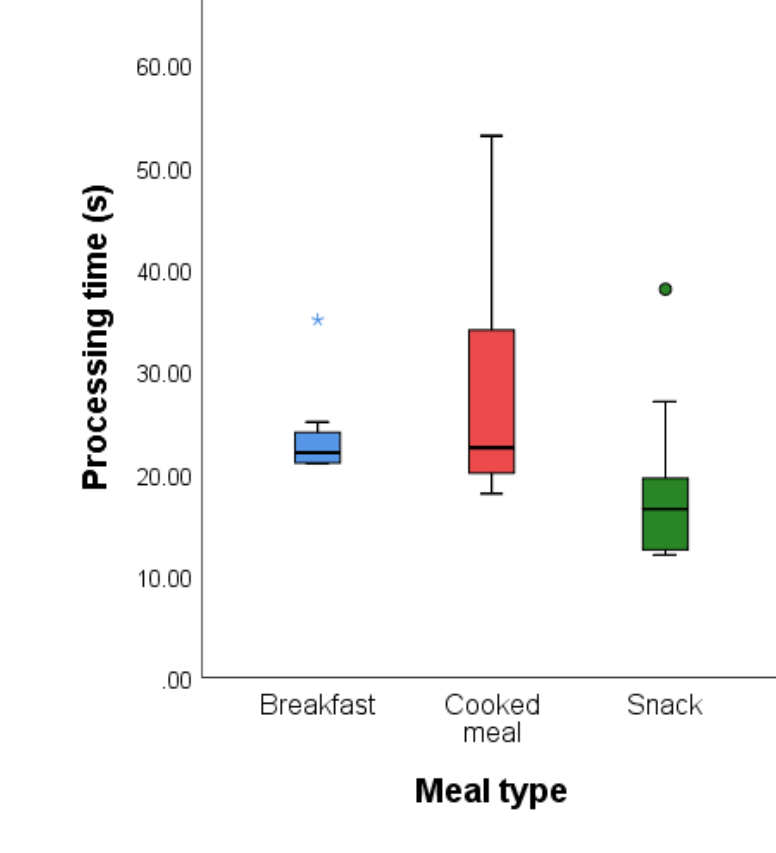
Figure 7. Box-plot of the processing time according to meal type. Box-plots show median values (solid line), interquartile range (IQR; box